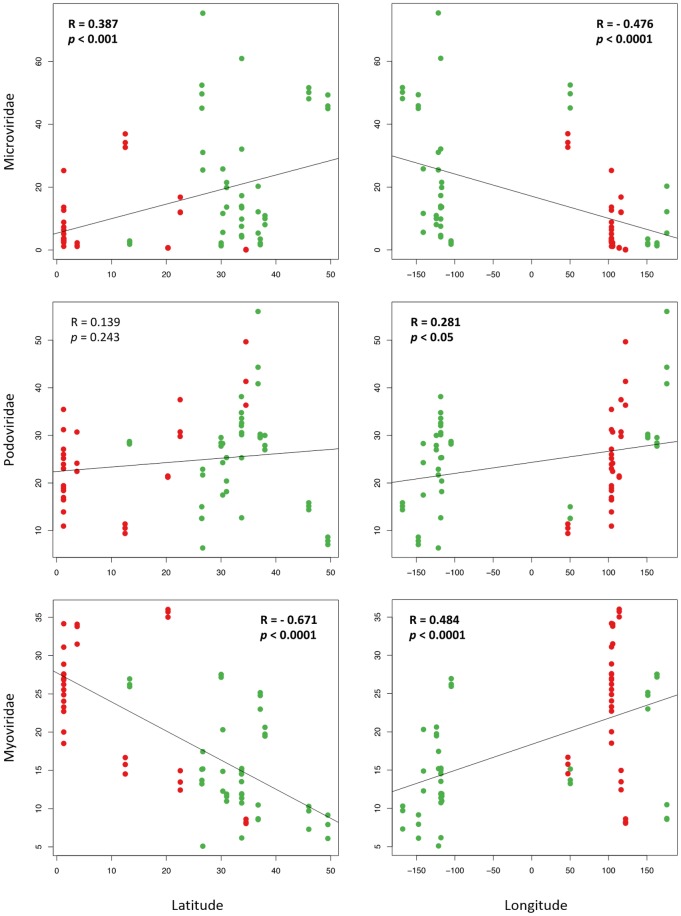
Response of the top three viral families contributing most to the virome dissimilarity between geographical variation.Relationship between relative abundances of Microviridae, Podoviridae, and Myoviridae and samples’ geographic origin was examined. Latitude and longitude are expressed in decimal scale. R was the Pearson correlation coefficient for the relative abundance of viral families against the either latitude or longitude in 72 data sets. Bold text indicates a statistical significance. Green and red dots represent vessels with ballast waters arriving in the Port of LA/LB and the Port of Singapore, respectively.